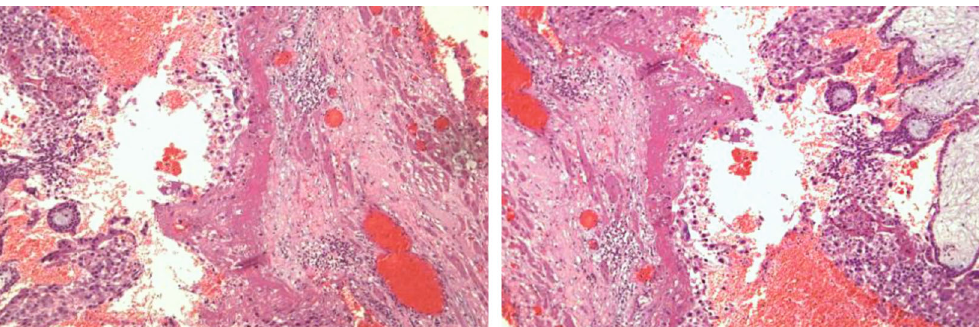
Figure 4: Implantation site with trophoblastic cells in the fallopian tube and chorionic villi in the